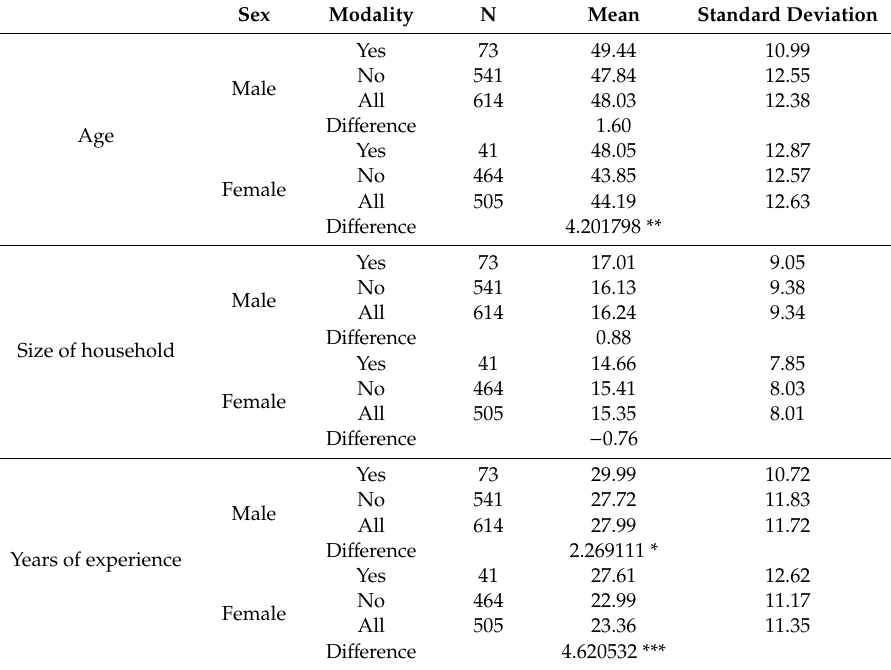
Table 4. Age, size of household and farmer experience in farming.